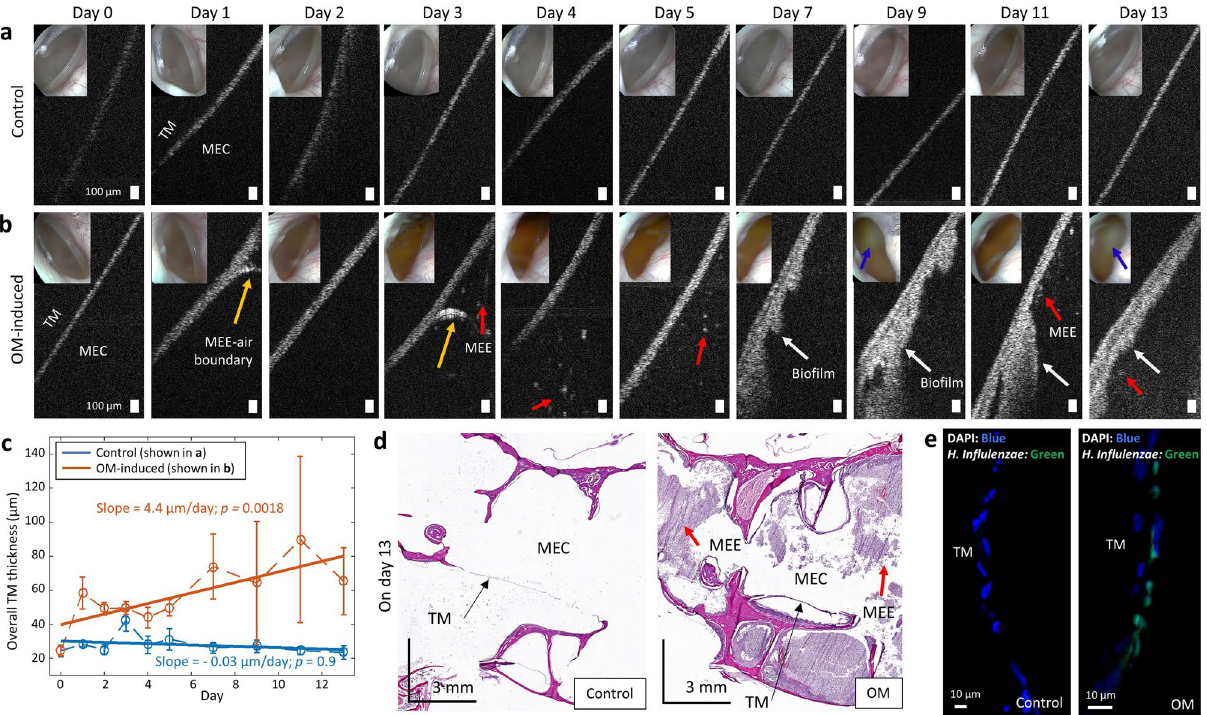
Figure 2. OM-induced changes in the middle ear cavity detected using OCT. Representative OCT and otoscopy (inset) images of ( a ) control chinchilla without induced AOM, and ( b ) AOM-induced chinchilla during the progression of OM. Yellow arrows indicate a MEE-air boundary, red arrows show scattering particle aggregates suspended in the MEEs, and white arrows indicate biofilm. Blue arrows in otoscopy images indicate white biomass behind the TM. ( c ) Plot of the averaged TM thickness measured from OCT with standard deviation for a specific animal shown in ( a , b ). The solid line was determined from the linear polynomial fitting. The corresponding p-value on the fitted slope was determined from a two-sided t test with the null hypothesis of a slope of zero. A positive slope with a p-value less than 0.05 indicates a significant increasing trend in the thickness. ( d ) Histologic images on day 13 demonstrate distinct differences in the middle ear cavity (MEC) where significant amount of MEE and immune cell infiltration were present in OM-affected bulla, but absent in the control without induced AOM. ( e ) Confocal laser scanning microscope images from fluorescence in situ hybridization (FISH). A nuclei stain (DAPI) detects unspecified genetic components, whereas the green fluorescence indicates the presence of Haemophilus influenzae on the TM. Scale bars in OCT, histologic images, and FISH represent 100 µm, 3 mm, and 10 µm,